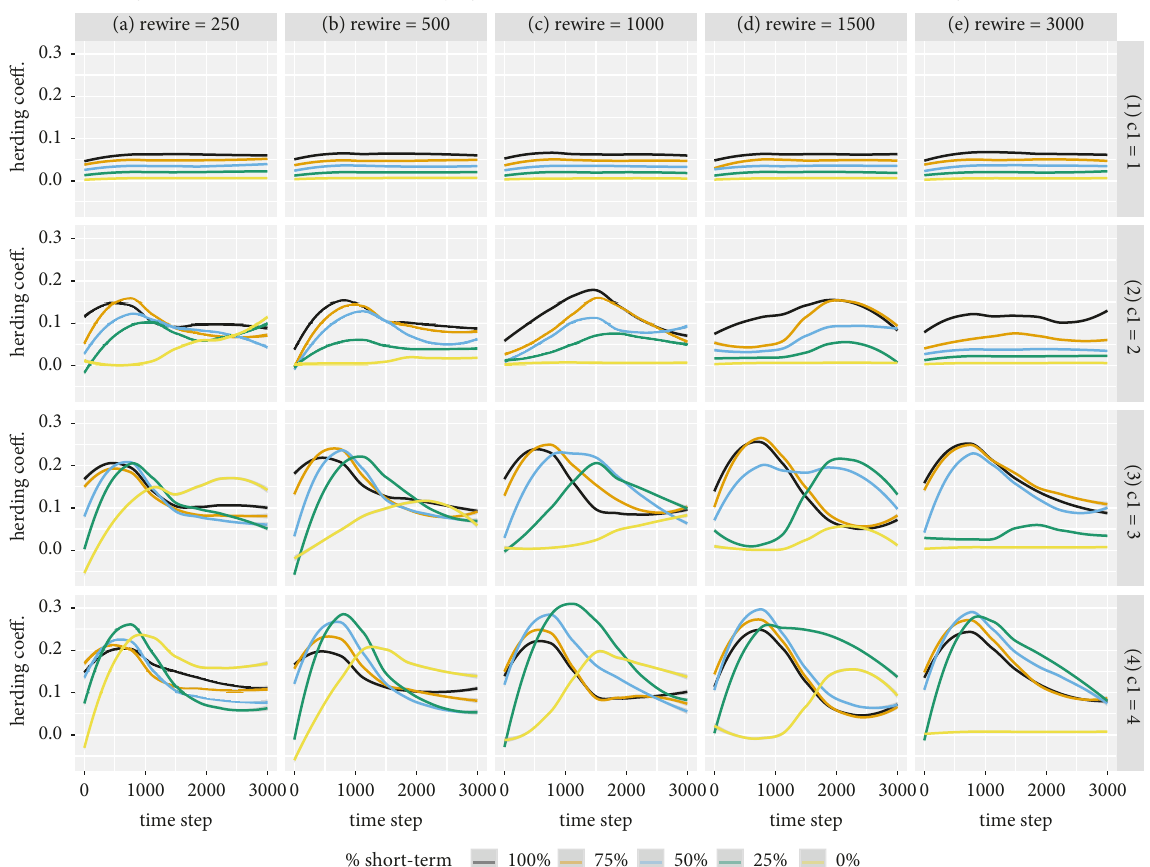
Figure 6: The evolution of the herding coefficient with rewiring. The lines come from applying a LOESS process to the standard deviation of the herding coefficient determined at each step from the runs of a specific experimental